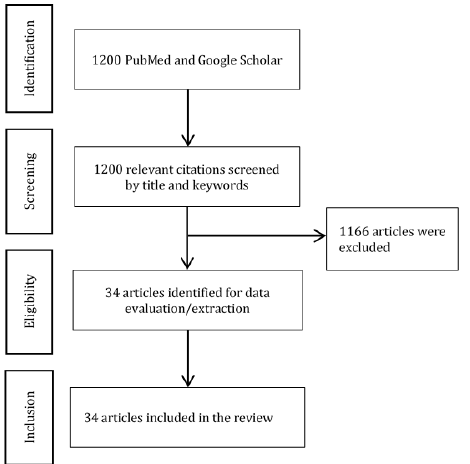
Figure 1. PRISMA diagram.